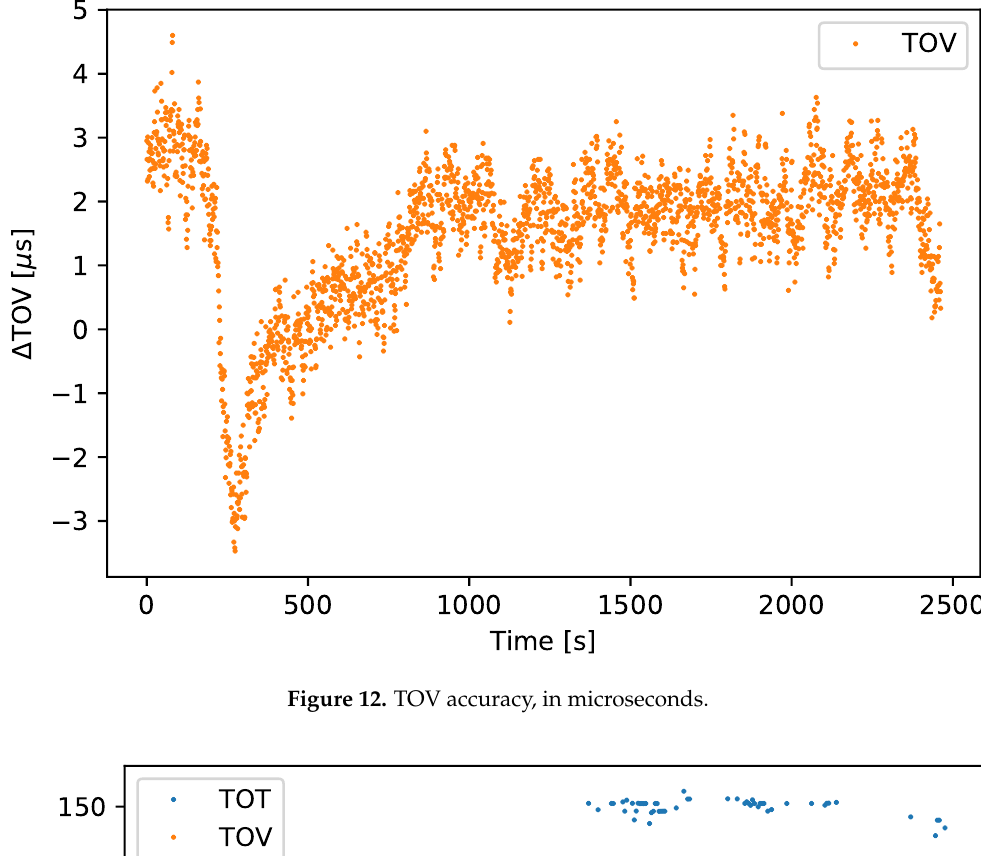
Figure 12. TOV accuracy, in microseconds.